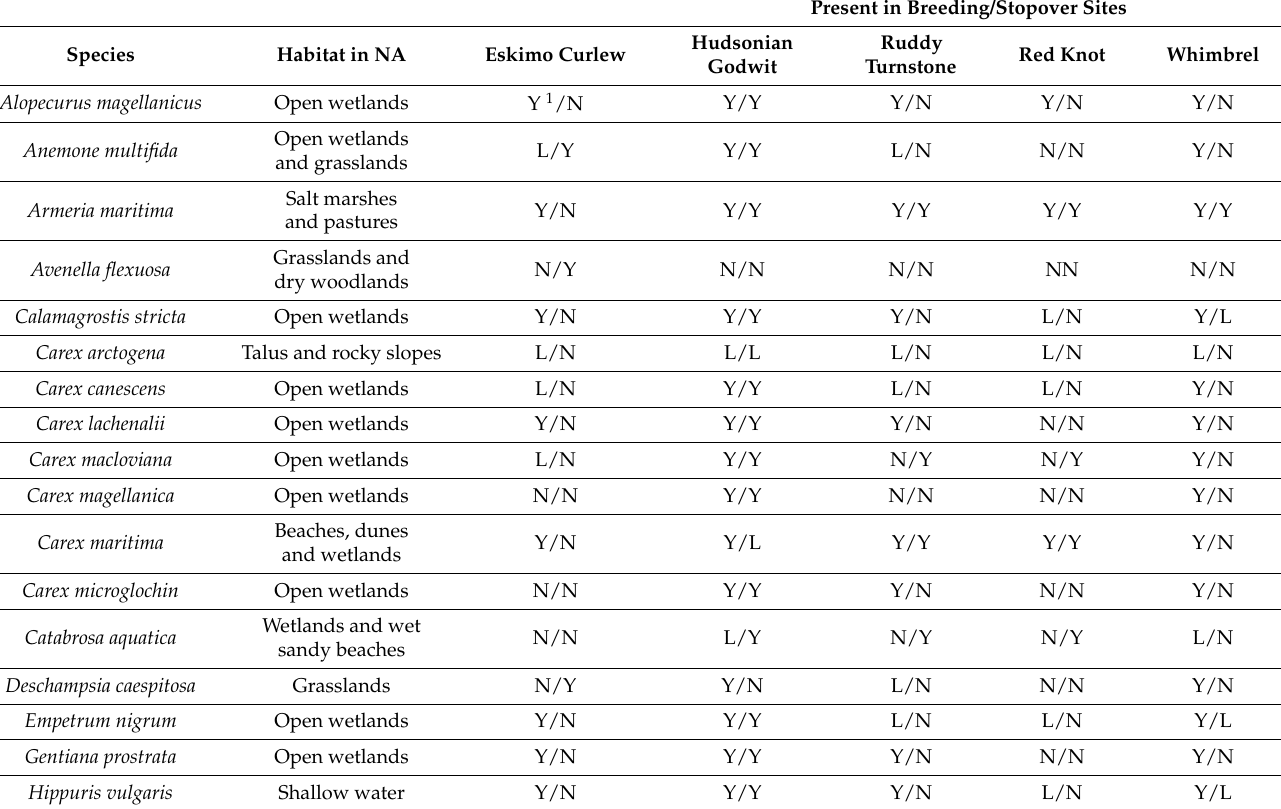
Table 3. Geographical range of the bipolar plant species and their overlap with the breeding ranges and staging areas of five shorebird